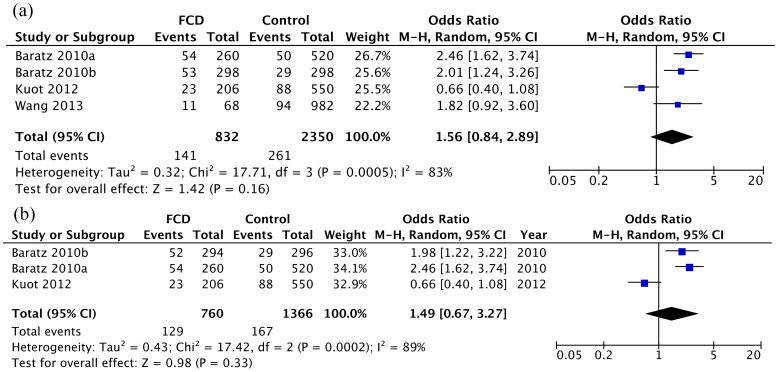
Forest plot of PTPRG allelic model: (a) PTPRG rs7640737 (b) PTPRG rs10490775.Squares indicate the study-specific odds ratio (OR). The size of the box is proportional to the weight of the study. Horizontal lines indicate 95% confidence interval (CI). A diamond indicates the summary OR with its corresponding 95% CI.